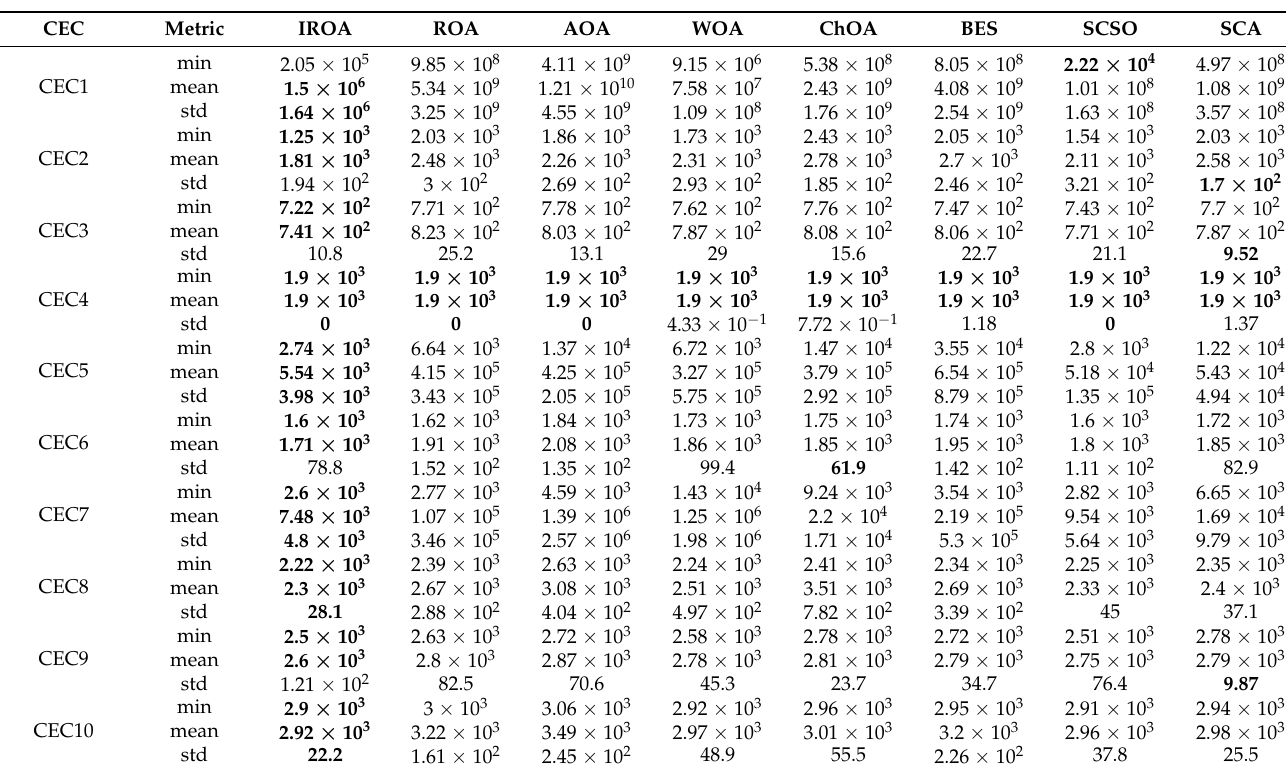
Table 6. Statistical results of 23 standard reference